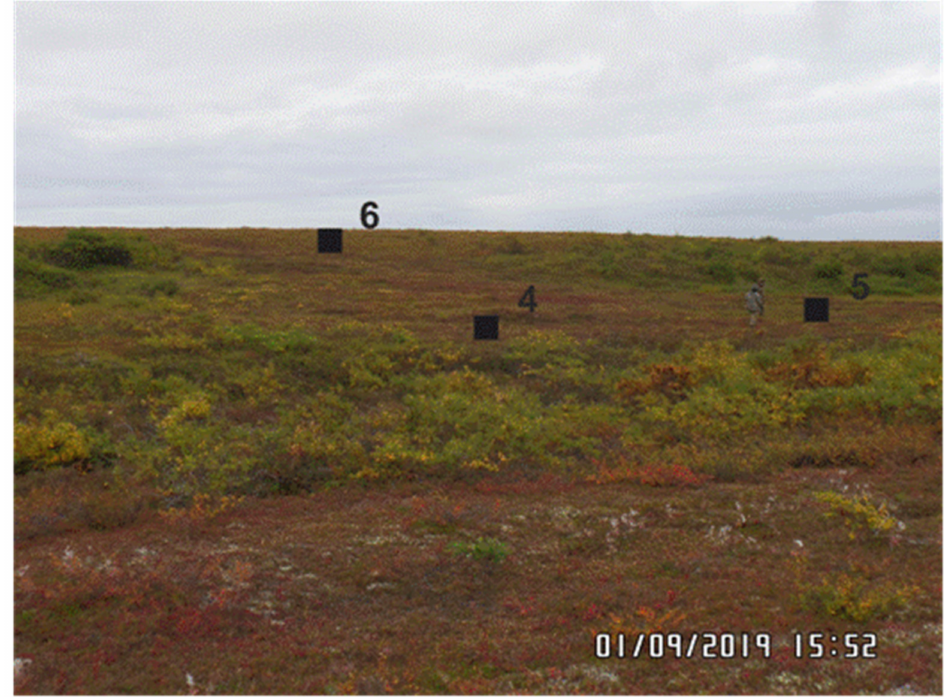
Figure 7. Layout of the pits for observations of suprapermafrost water flow during the second field